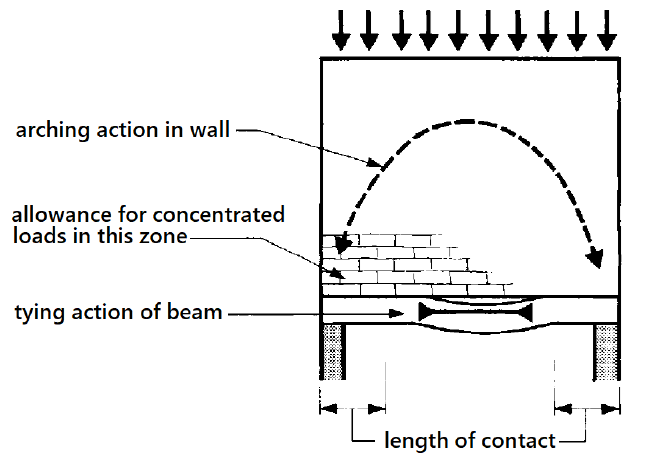
Figure 1. Joint action of the wall-beam system. Adapted: Haseltine, Moore